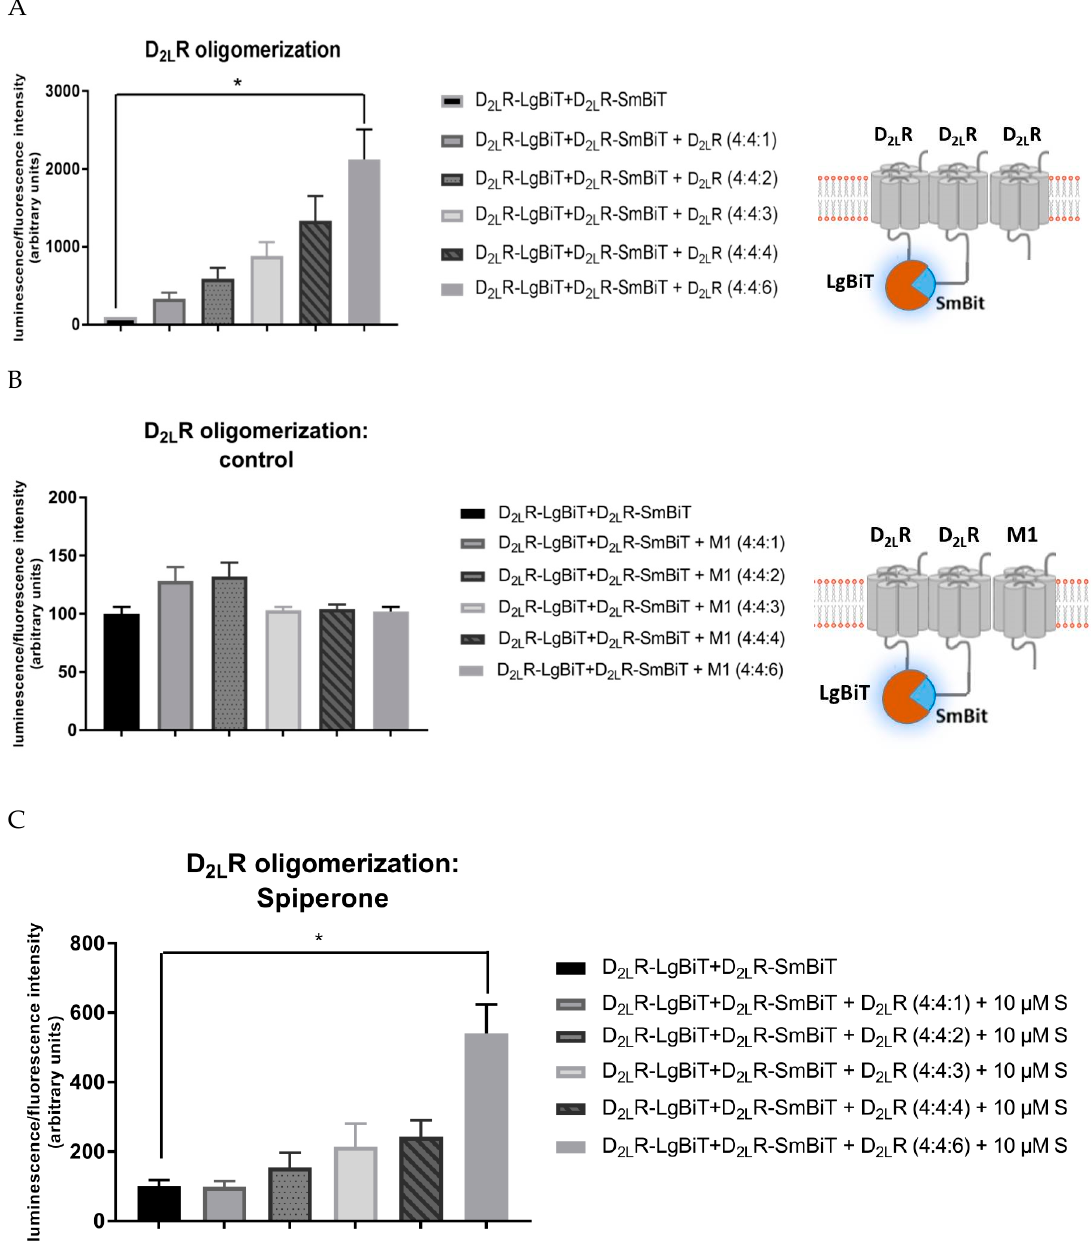
Figure 5. HEK293T cells transiently expressing higher levels of D 2L R (fusion) proteins. ( A ) An increasing amount of native D 2L R was co-transfected with D 2L R–LgBiT and D 2L R–SmBiT vectors. Higher expression levels of D 2L R stimulate D 2L R oligomerization. ( B ) An increasing amount of native muscarinic M1 receptor does not attenuate nor evoke higher luminescent signals evoked by D 2L R dimerization. ( C ) Incubation of cells with 10 µ M spiperone (S) results in a less pronounced increase of D 2L R di- and oligomerization upon expression of increased levels of native D 2L R. Experiments were performed three times in triplicate. ( n = 3, ± SEM) (non-parametric Kruskal–Wallis one-way Anova, followed by post-hoc analysis (Dunn’s multiple comparison test), * p < 0.05).